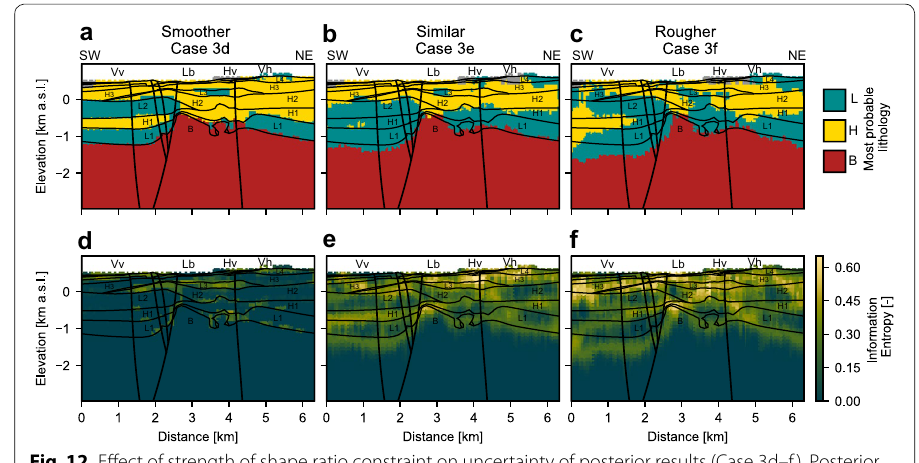
Fig. 12 Effect of strength of shape ratio constraint on uncertainty of posterior results (Case 3d–f). Posterior results for ( a – c ) most probable lithology and ( d – f ) information entropy, for inversion runs with ( a , d ) smoother shape ratio constraint (Case 3d), ( b , e ) similar shape ratio constraint (Case 3e), ( c , f ) rougher shape ratio constraint (Case 3f). Results are shown along Section